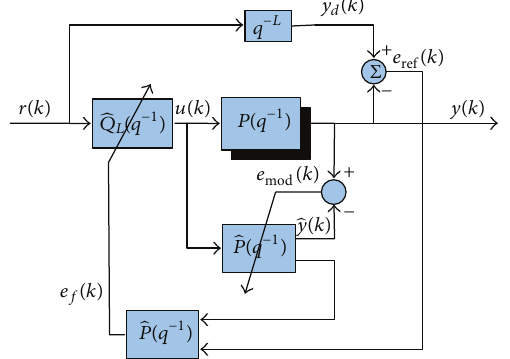
Figure 1: Direct adaptive inverse control.